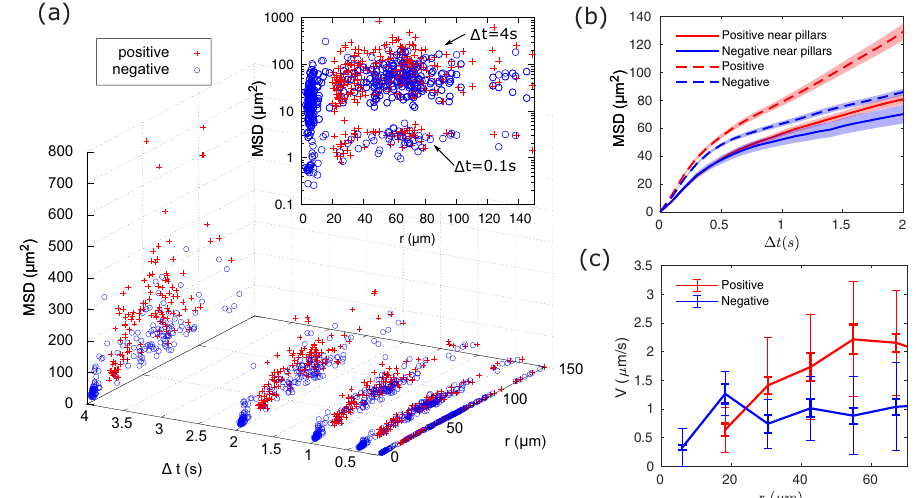
Fig. 3 Activity of topological defects. a The mean squared displacement (MSD) of defects (obtained by moving average along the trajectory) as a function of time interval ( Δ t ) and the average distance to the nearest pillar ( r ). Inset: The MSD vs r in semilogarithmic scale for two time intervals Δ t . Each point represents the MSD of a defect. b The MSD of defects as a function of time near pillars (25 μ m < r < 35 μ m, solid line) and far from pillars ( r > 140 μ m, dashed line). Shaded regions represent the uncertainty resulting from averaging different MSD of defects, red for positive and blue for negative defects, correspondingly. The uncertainty is computed as the standard error of the mean (SEM). The corresponding values of diffusion coef fi cients are: D + = 12.2 ± 0.2 μ m 2 s − 1 , D − = 5.8 ± 0.2 μ m 2 s − 1 at distance from a pillar and D + = 6.3 ± 0.2 μ m 2 s − 1 , D − = 4.8 ± 0.2 μ m 2 s − 1 in the pillar vicinity. c Average defect speeds measured over the entire duration of the track as a function of their average distance to the nearest pillar. Error bars show standard deviation (thin lines) and the standard error of the mean (thick pillar center, while positive defects accumulate at d ≈ 15 − 20 μ m (Fig. 4e, f). The effective diffusivity of positive and negative distance from the pillar center [Fig. 4a – d], in agreement with the defects drops from D + = 24.7 μ m 2 s − 1 , D − = 5.6 μ m 2 s − 1 to D + = 13.9 μ m 2 s − 1 and D − = 4 μ m 2 s − 1 . Since the motion of experimental fi ndings [Figs. 2 and 3] and Supplementary experimental Videos 3, 4 and simulation Videos 5, 6. Like in defects is not a purely normal diffusion, the provided values are the experiment, the distribution of positive defects has maxima given for a typical lifetime of defects Δ t = 5 – 8 s. near the concave segments of the pillar, Figs. 2b and 4c. The We have found from the simulations that while positive defect proximity of pillars also leads to a reduction of defect mobility accumulation near a pillar is robust, the defect distributions are